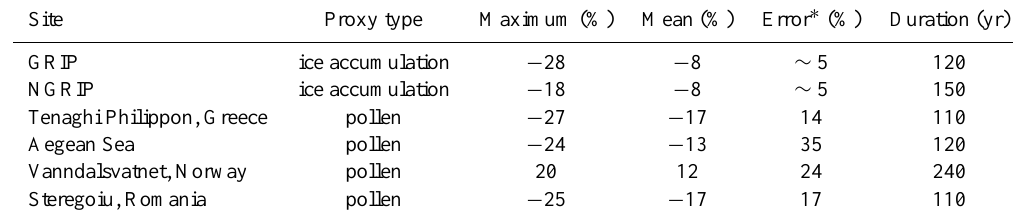
Table 2. Quantitative mean annual precipitation anomalies from early Holocene background values. Site Proxy type